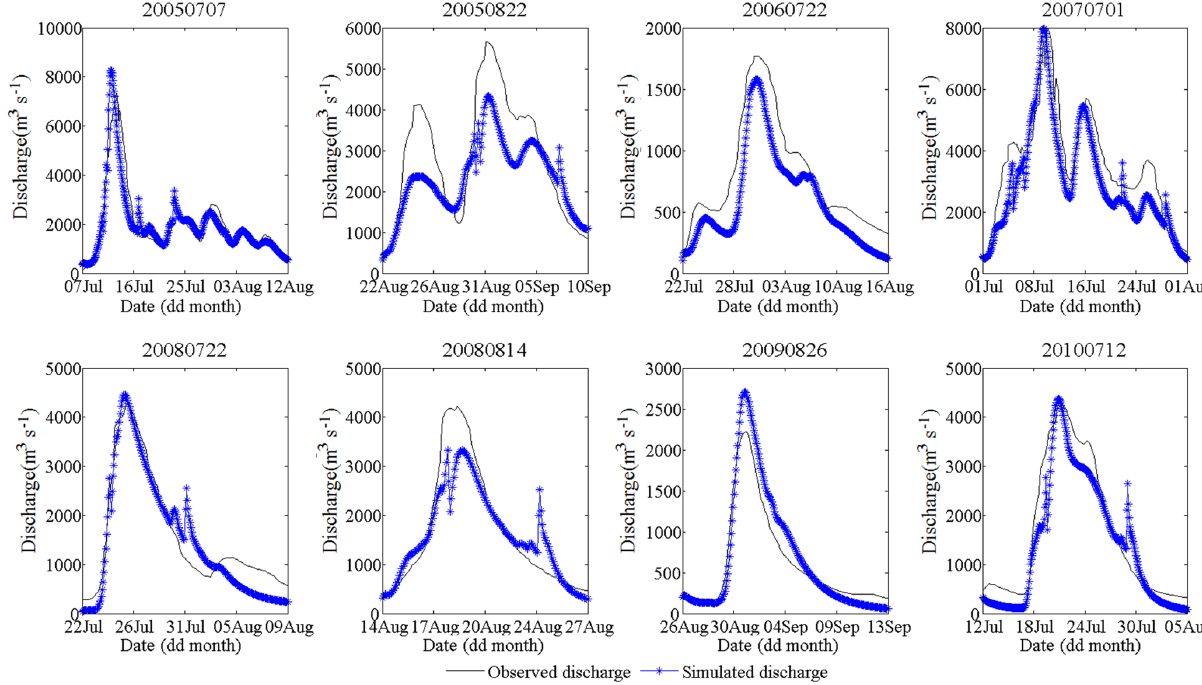
Figure 7. Comparisons between the observed and simulated sub-daily flood events for the validation period at WJB. Table 4. Calibrated parameter values for the SWAT model and the SWAT-EVENT model. Event-based simulation with Daily simulation with the SWAT model the SWAT-EVENT model Value for long-term Value for flood Parameter period calibrating period calibrating Parameter Value